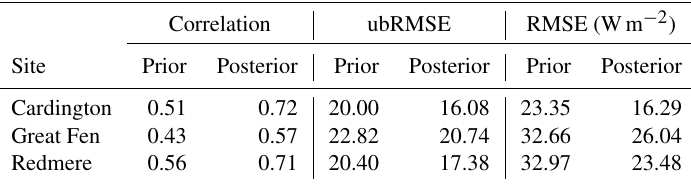
Figure 17. Time series of heat flux variables and soil moisture at Redmere flux tower site. Black crosses: flux tower observations, grey crosses: SMAP observations for closest 9km pixel, blue line: prior JULES estimate for closest 1km grid cell, orange line: posterior JULES estimate for closest 1km grid cell. Table 4. Summary statistics for comparison of JULES-CHESS latent heat estimates to flux tower observations over the experiment period. Over all sites, we find a 34% increase in correlation, 15% reduction in ubRMSE and 26% reduction in RMSE after performing the calibration using